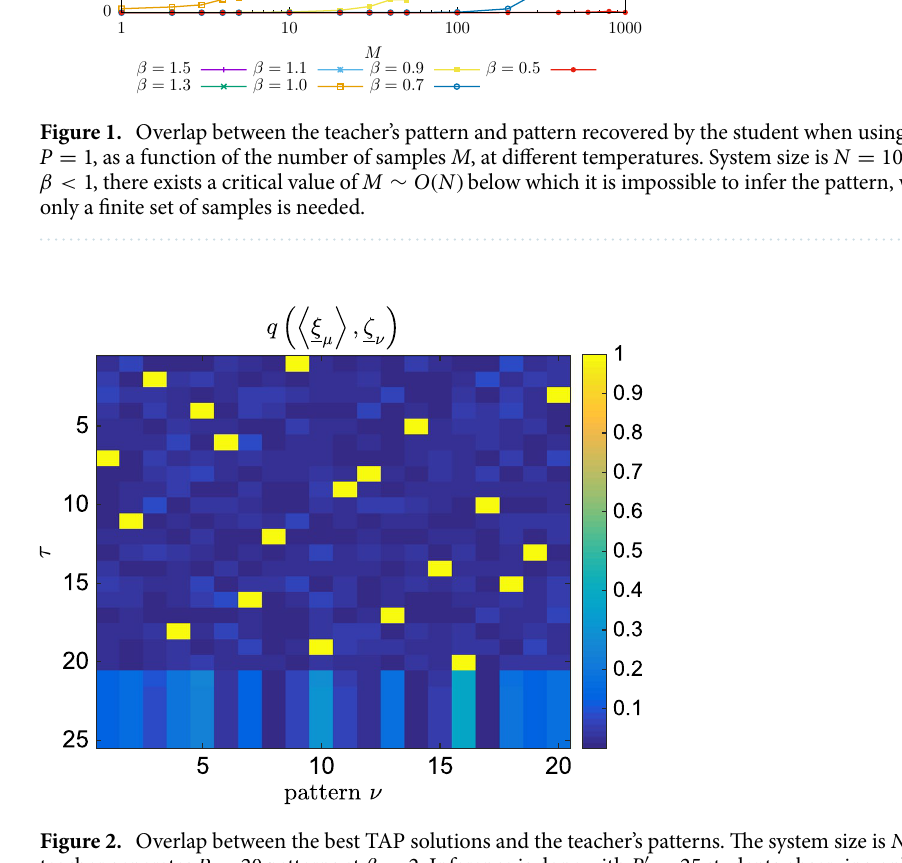
Figure 2. Overlap between the best TAP solutions and the teacher’s patterns. The system size is N 20 patterns at β 25 students observing only M 2 . Inference is done with P teacher generates P ′ = = = 1 . . . , P samples, i.e. 10 per state. At each iteration step τ ′ , we pick the best TAP solution and we plot its = overlap with all of the teacher’s patterns. We observe clearly that the students are able to retrieve all the patterns from the